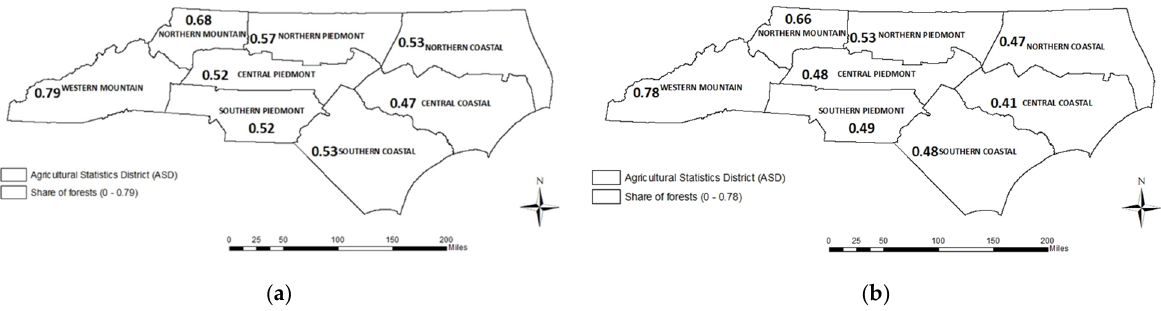
Figure 1. Map of Agricultural Statistical Districts (ASDs) in North Carolina based on the share of forestland in CDL ( a ) and share of forestland in the NLCD ( b ). forestland in CDL ( a ) and share of forestland in the NLCD ( b